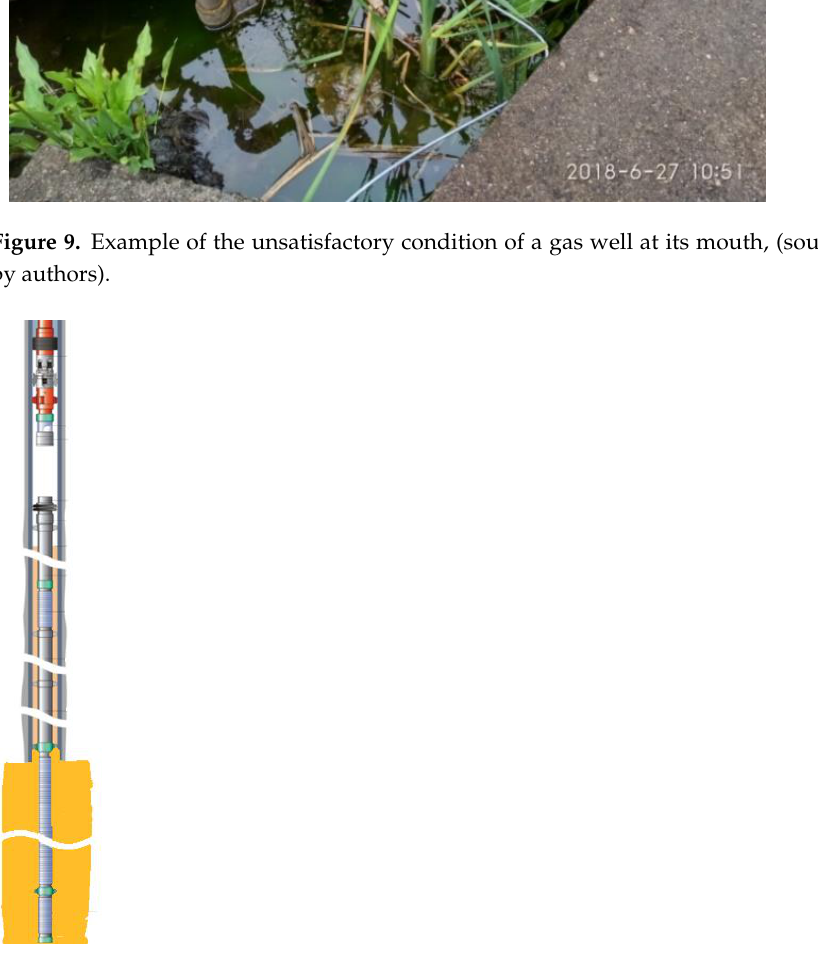
Figure 9. Example of the unsatisfactory condition of a gas well at its mouth, (source: elaborated by authors).